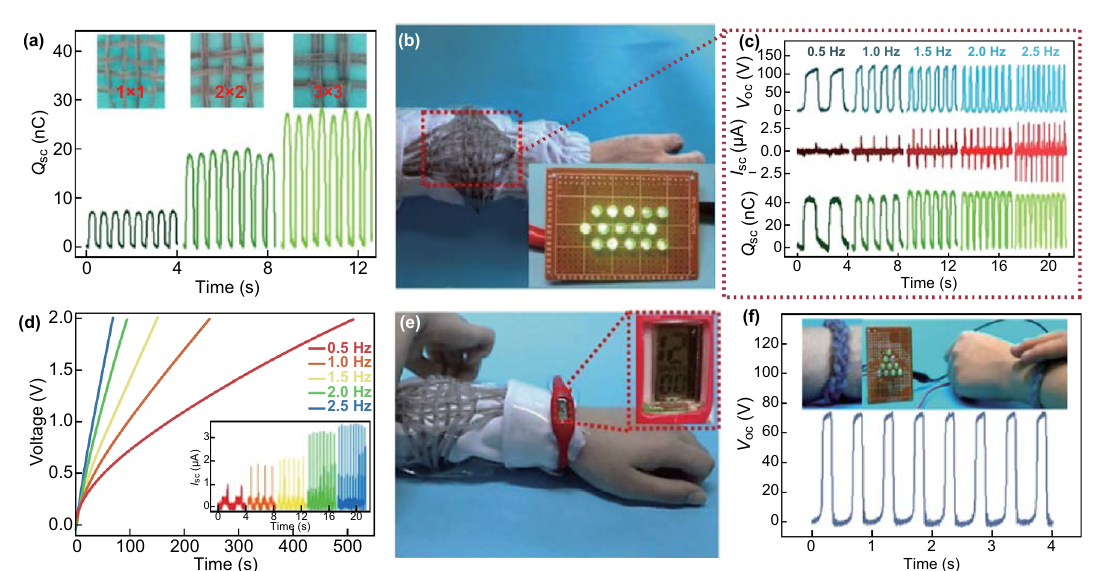
Fig. 4 Demonstration of the FST–TENG‑based fabric as wearable power source. a Q sc of the TENG fabric with knitting patterns of 1 × 1, 2 × 2, and 3 × 3 nets. b Photograph of the FST–TENG‑based fabric, which enables to light up 15 green LEDs by hand tapping. c Electrical outputs of the TENG fabric under various motion frequencies ranging from 0.5 to 2.5 Hz, including V oc , I sc , and Q sc . d Charging curves of a capacitor (10 μF) charged by the FST–TENG fabric at various motion frequencies. Inset shows the current output of the FST–TENG fabric after rectifica‑ tion. e Photograph of the self‑charging powered system driving an electronic watch. f V oc of the FST–TENG‑based bracelet at the motion fre‑ quency of 2 Hz. Inset shows the photograph of 10 green LEDs lighted up by hand